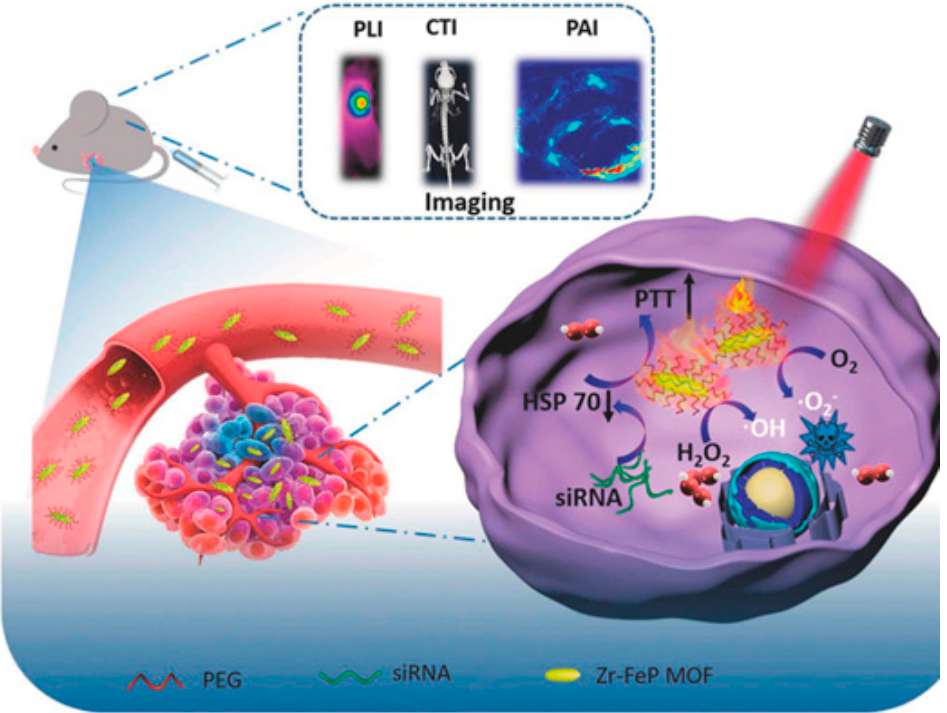
Figure 8. siRNA/Zr ‐ FeP MOF mediates PTT at a lower temperature and PDT for cancer. Reprinted Figure 8. siRNA/Zr-FeP MOF mediates PTT at a lower temperature and PDT for cancer. Reprinted with permission from with permission from Ref. [46]. Copyright 2018, Elsevier B.V. Ref. [46]. Copyright 2018, Elsevier